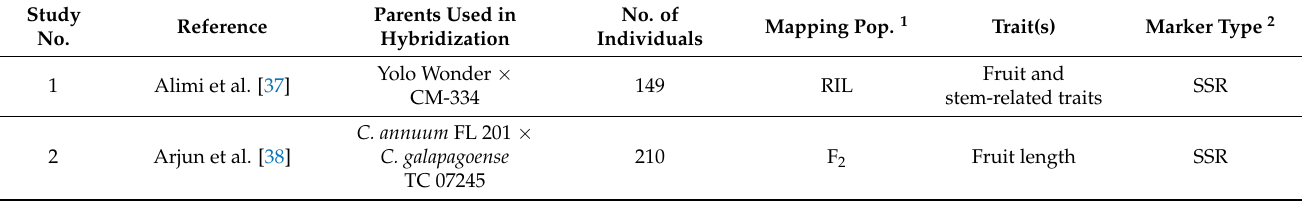
Table 1. Summary of QTL mapping studies used for meta-analysis of diverse traits for the Capsicum QTLome. Study